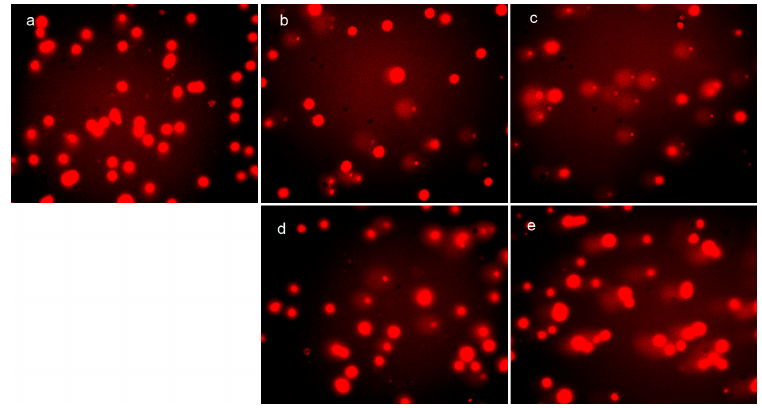
Figure 5. In vivo ROS generation and DNA fragmentation (comet tail) induced by DpdtpA and its